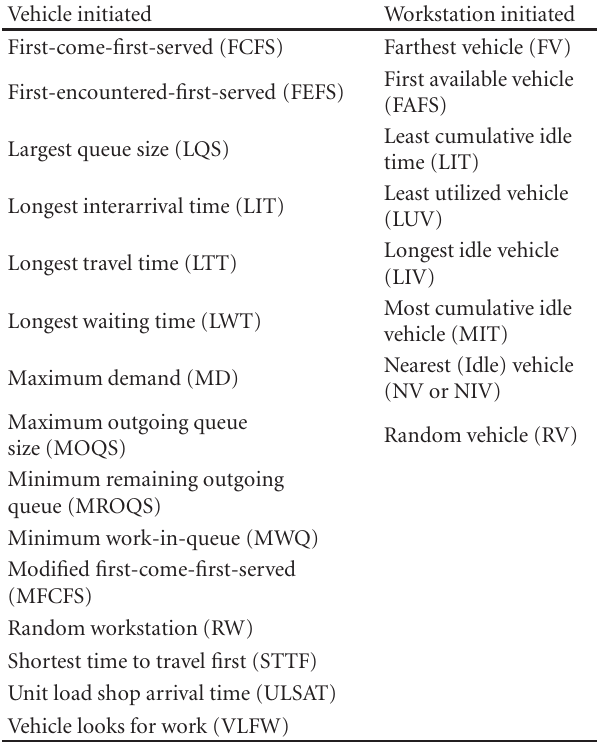
Table 1: Summary of AGV dispatching